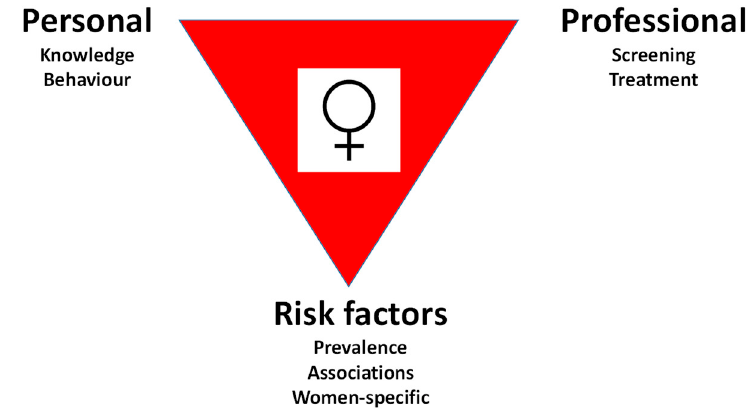
Figure 3. Types of female disadvantage in cardiovascular disease.